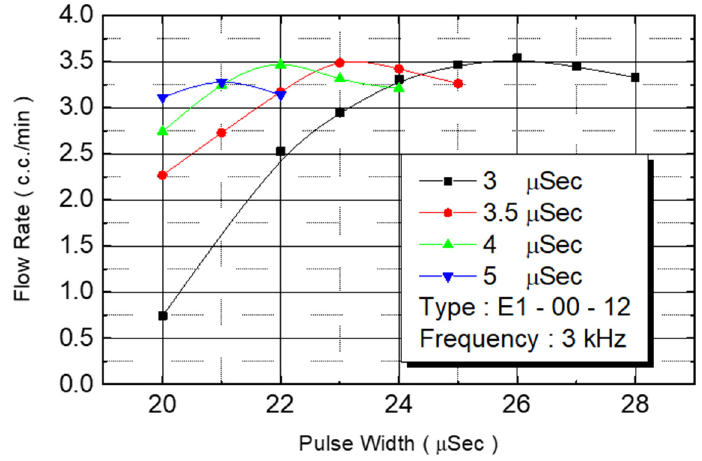
Figure 16. E1 type flow test.